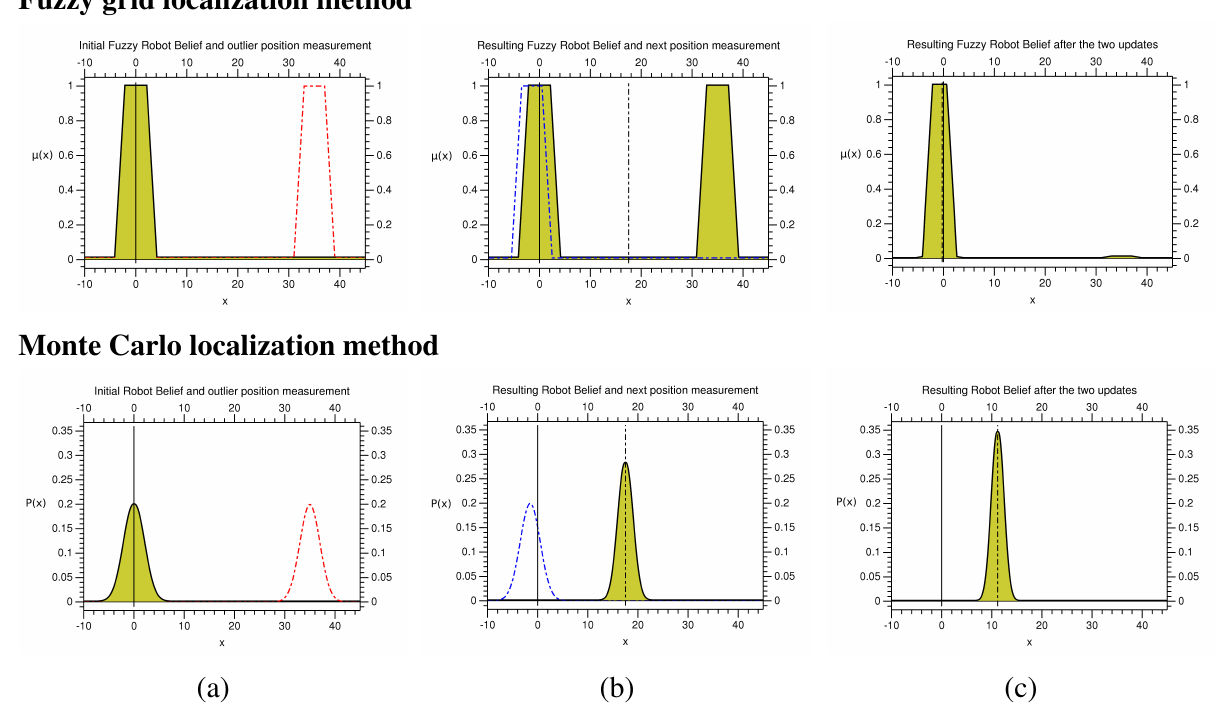
Figure 10. Example of location information fusion using the proposed and the reference localization